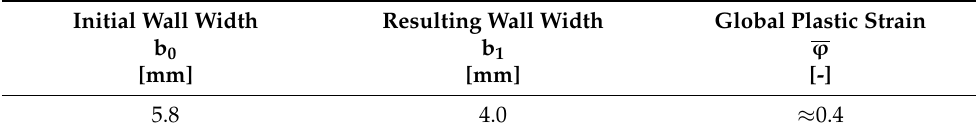
Table 3. Forming parameters to obtain certain plastic